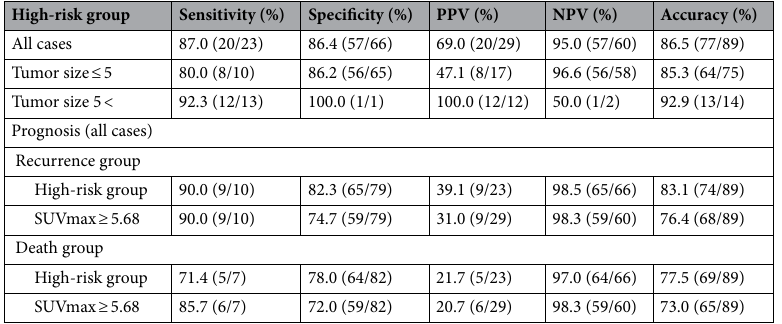
Table 2. Diagnostic accuracy of high-risk, recurrence, and death groups using a cutoff of SUVmax ≥ 5.68. PPV, positive predictive value; NPV, negative predictive value.